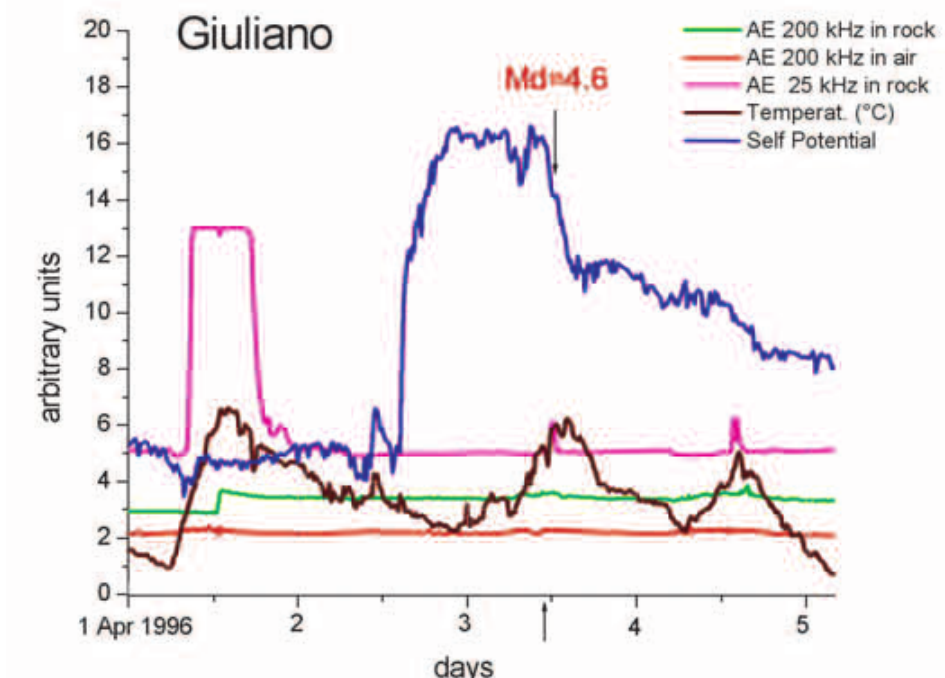
Fig. 4b. Time delay between the relative variations of AE at 25 kHz ( purple), the same at 200 kHz in rock (green), and in air (red), plus self-potential (blue). Units on ordinate scale are arbitrary (see fig. 1). A ~ 2 days precursor appears in the LF AE, and a lesser one in the HF AE in rock. This is associated with an increased porosity of ground, by which the fluid-flow increases, and one day later also the self-potential. When the self-potential starts = 4.6 earthquake occurs with epicentre at ~ 18.2 km from the recording site. Redrawn after recovering, an M d Cuomo et al.